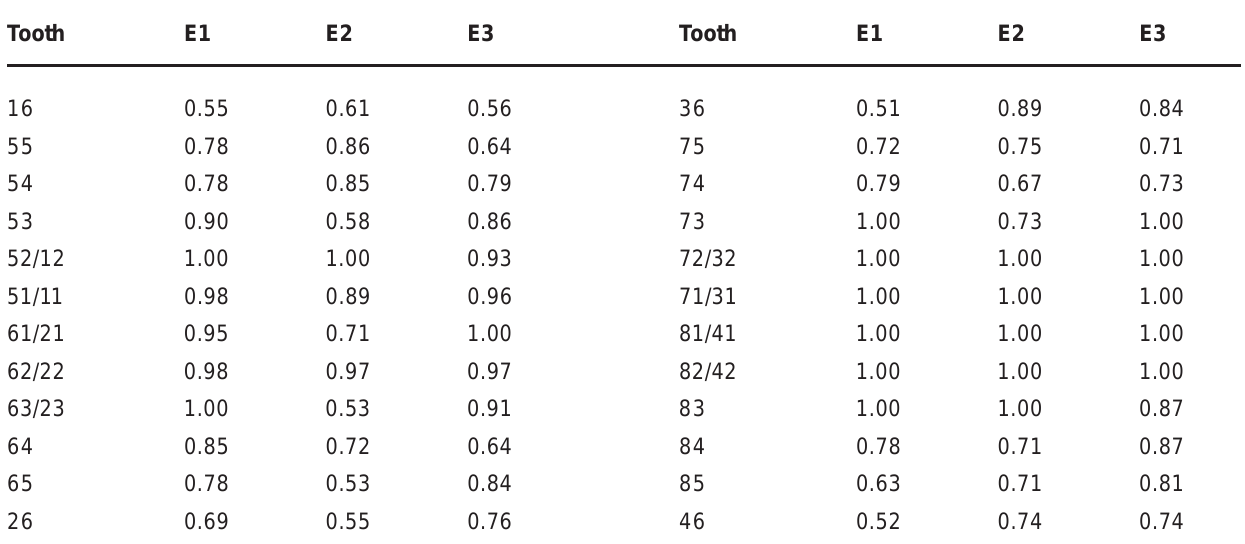
TABLE 4- Mean Kappa values for interexaminer reliability (interval of variation) under the WHO+IL caries diagnosis threshold, according to calibration exercises and teeth. Piracicaba,